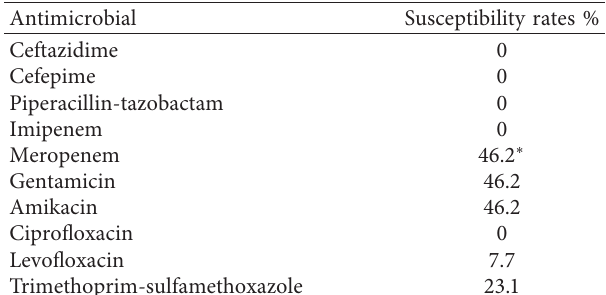
Table 4: Susceptibility profiles of 13 strains of carbapenem-re- sistant A. baumannii isolated from blood stream infections in the intensive care. ∗ MIC ranges for meropenem 1–256 µ g/ml.